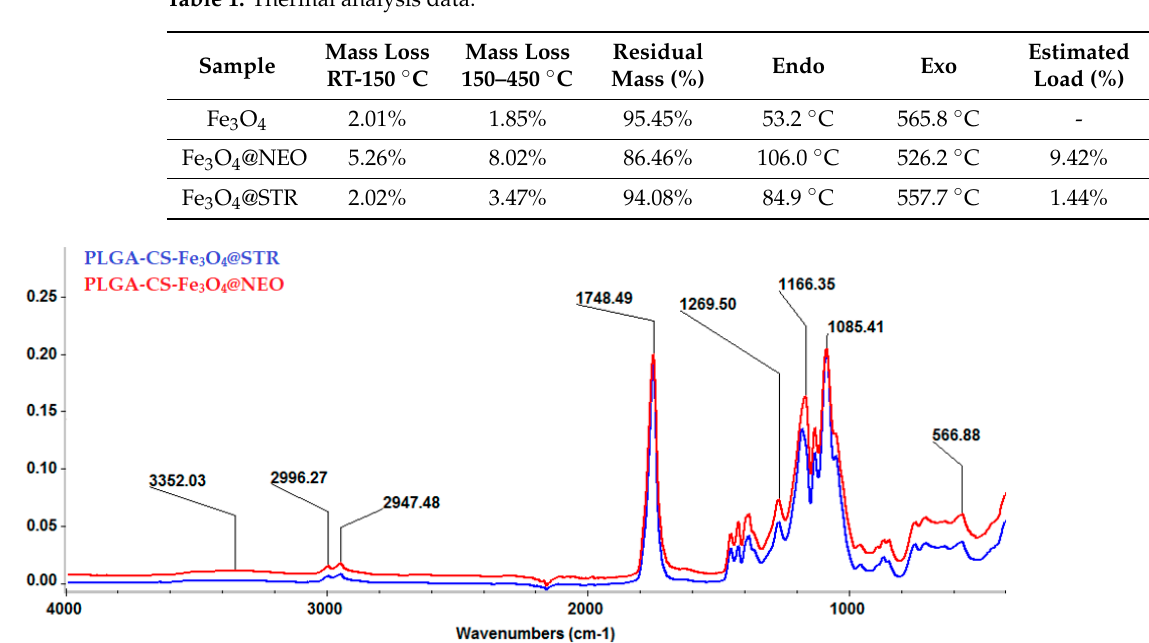
Figure 7. FT-IR spectra of PLGA-CS-Fe 3 O 4 @STR and PLGA-CS-Fe 3 O 4 @NEO spheres. SEM micrographs (Figure 8a,b) of composite spheres showed a compact spherical shape. The diameter of the obtained spheres varies from submicron up to several microns, with an average of around 1 μm.